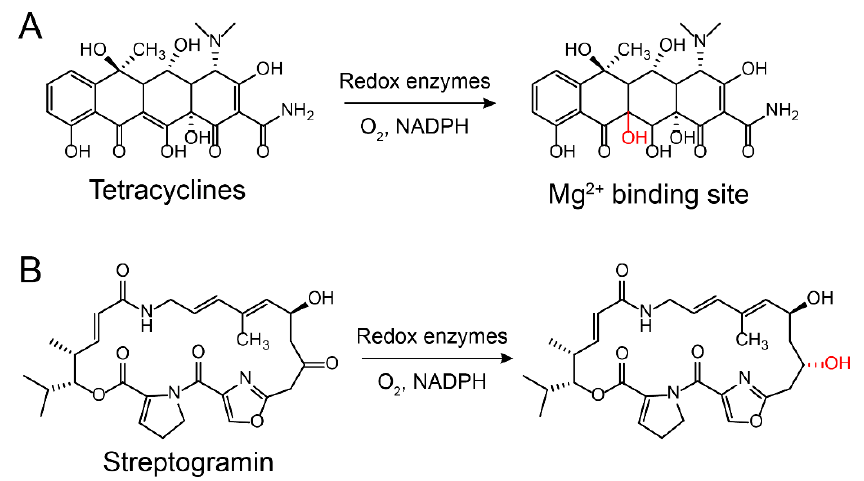
Figure 7. Inactivation of ( A ) tetracycline and ( B ) streptogramin by redox enzymes [95–97].